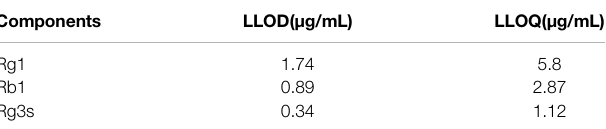
TABLE 3 | LLOD and LLOQ of HPLC